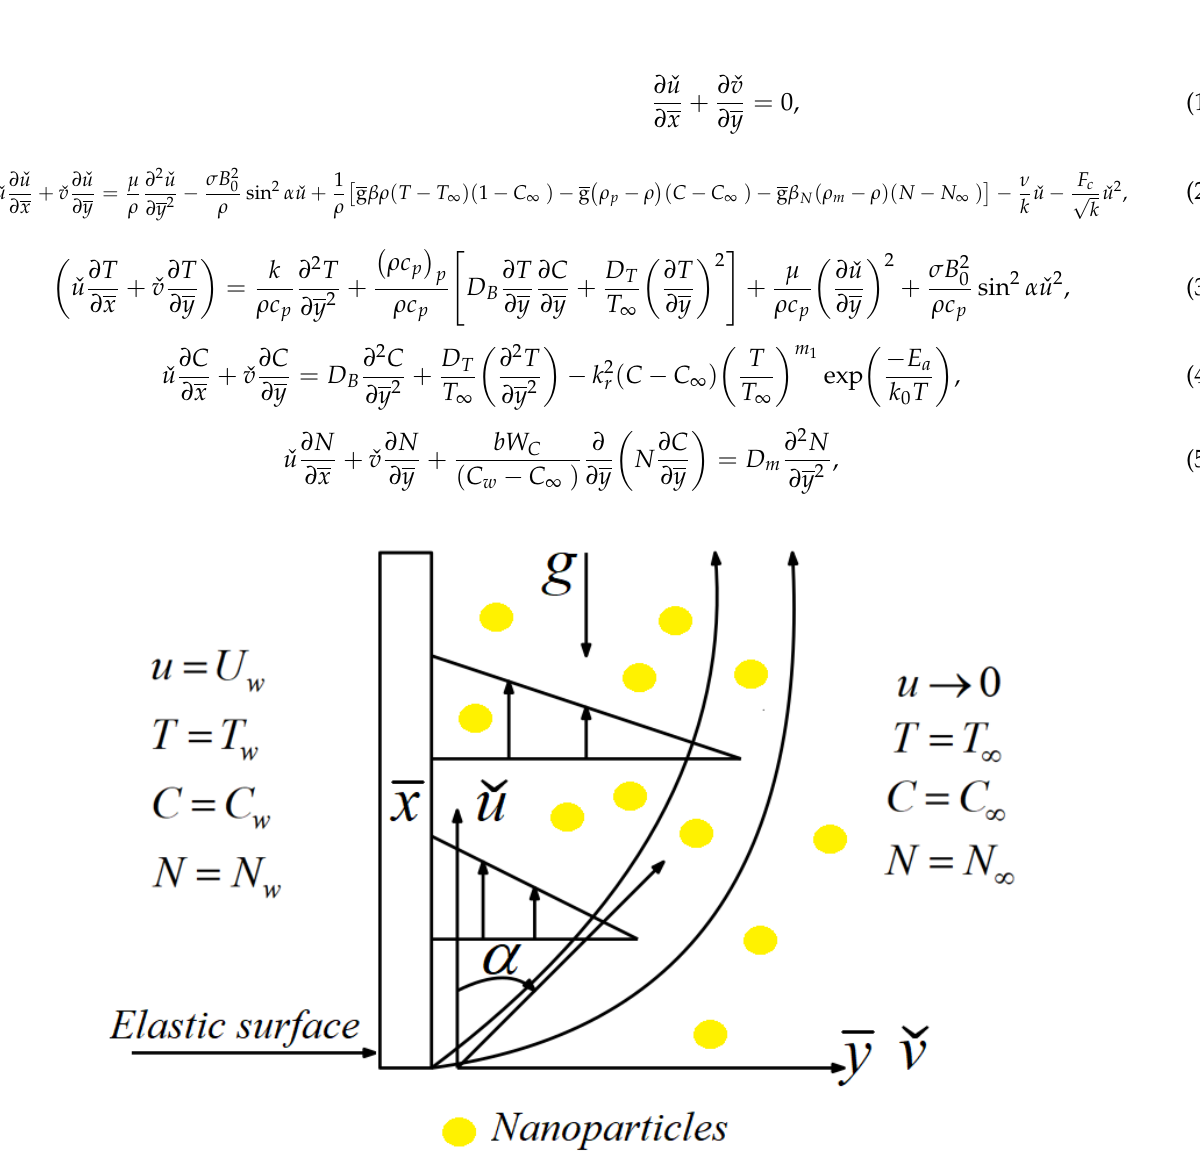
Figure 1. Schematic flow diagram.